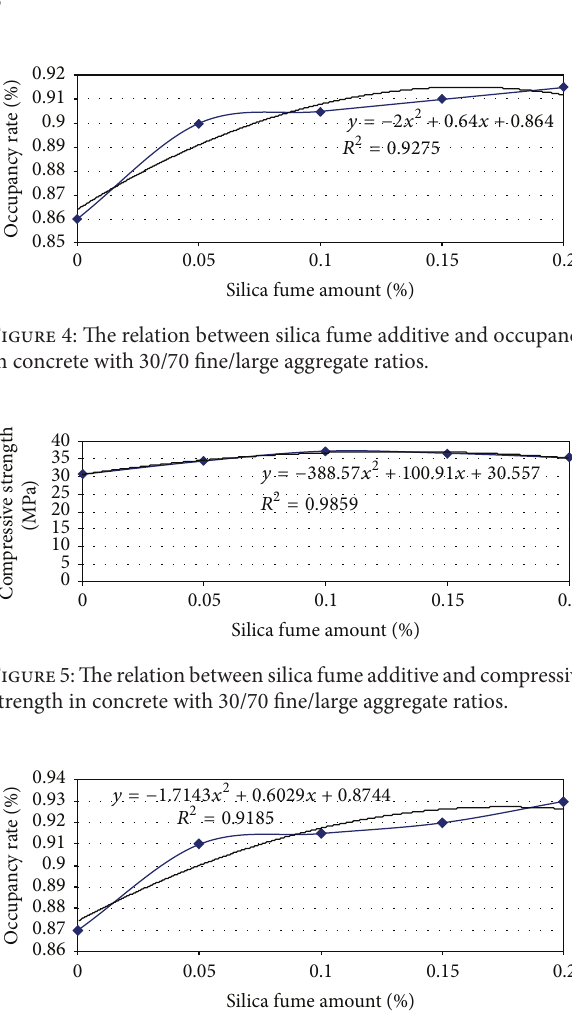
Figure 6: The relation between silica fume additive and occupancy in concrete with 35/65 fine/large aggregate ratios.